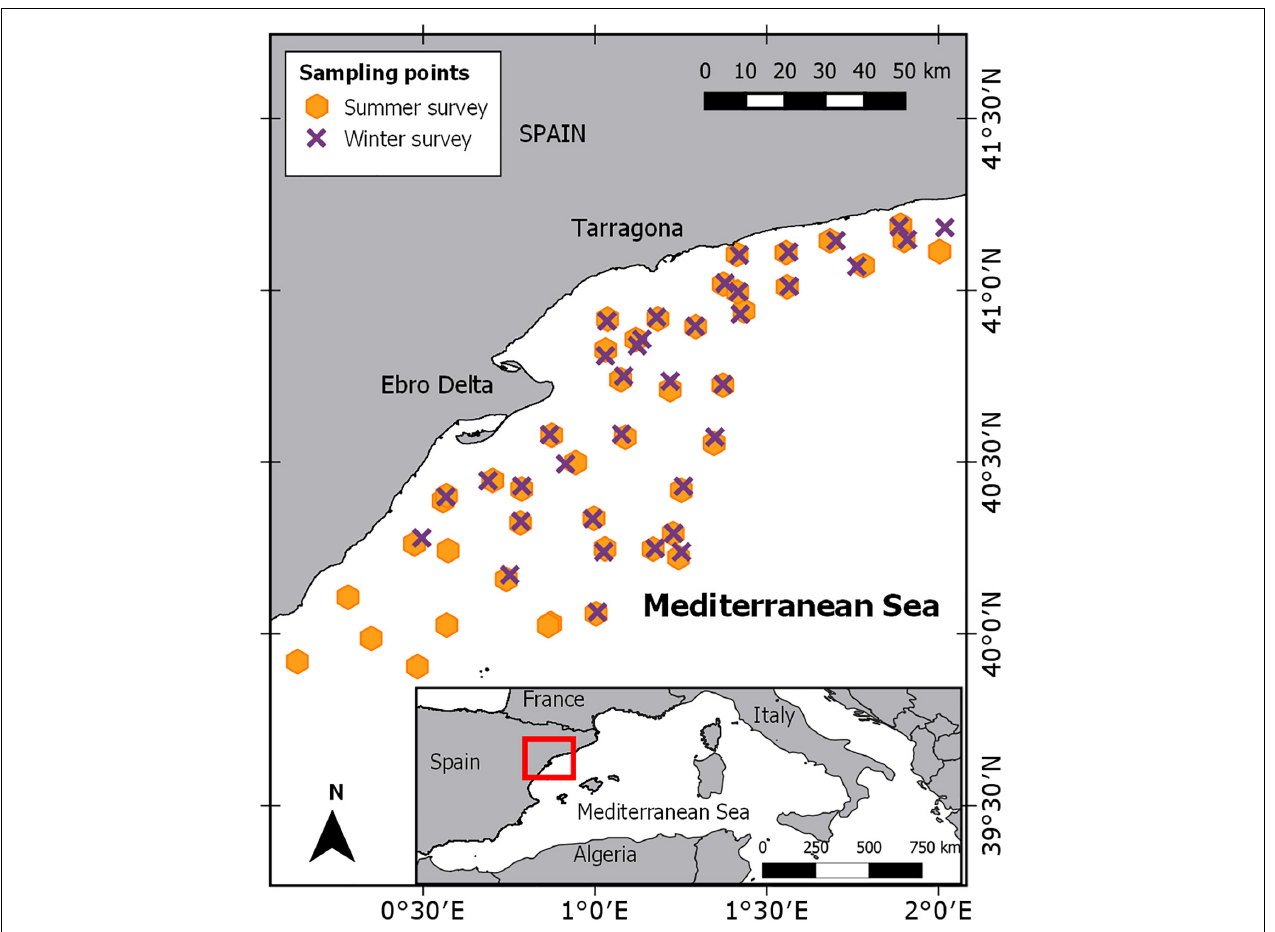
FIGURE 1 | Study area and geographical positions of the sample sites of ECOTRANS survey for winter and summer.